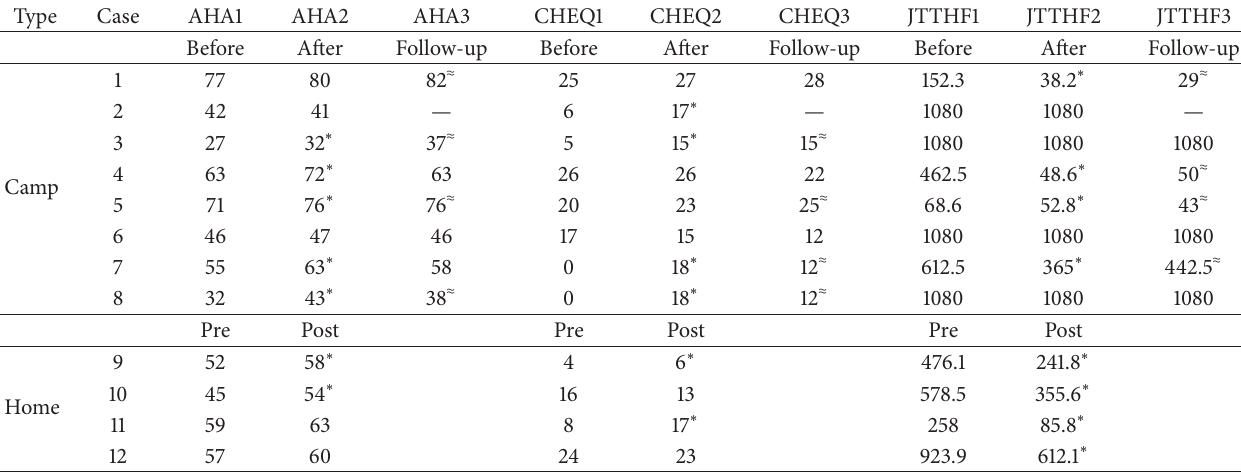
Table 2: Individual behavioral scores for all participants before and after treatment and at six-week